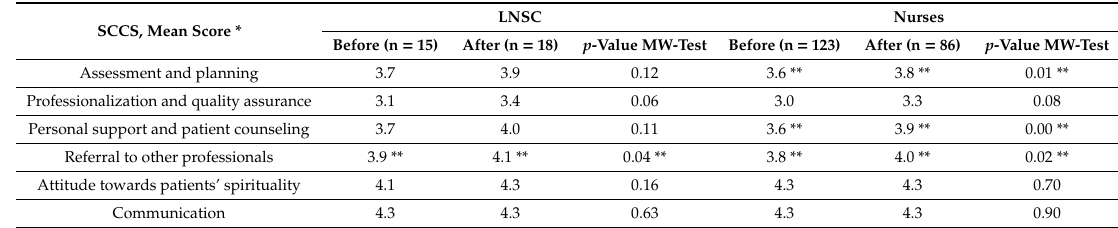
Table 4. Spiritual care competency scale (SCCS)